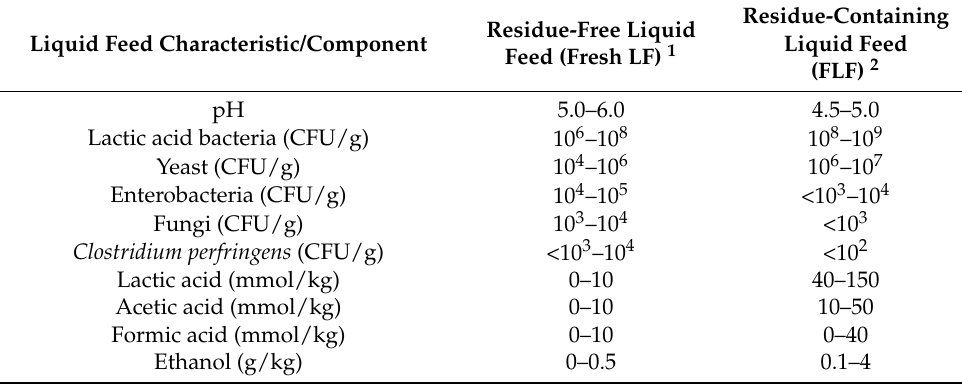
Table 1. Standard pH values, microbiological parameters and organic acid levels in residue-free and residue-containing liquid feed